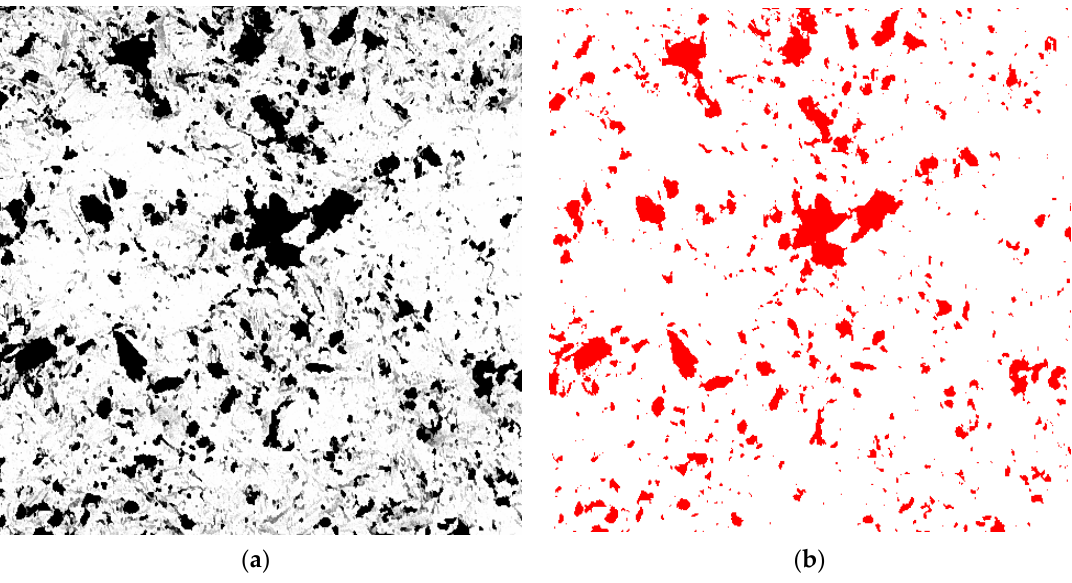
Figure 2. Binarization of microscopic image: ( a ) initial image and ( b ) image after binarization (for calculations).